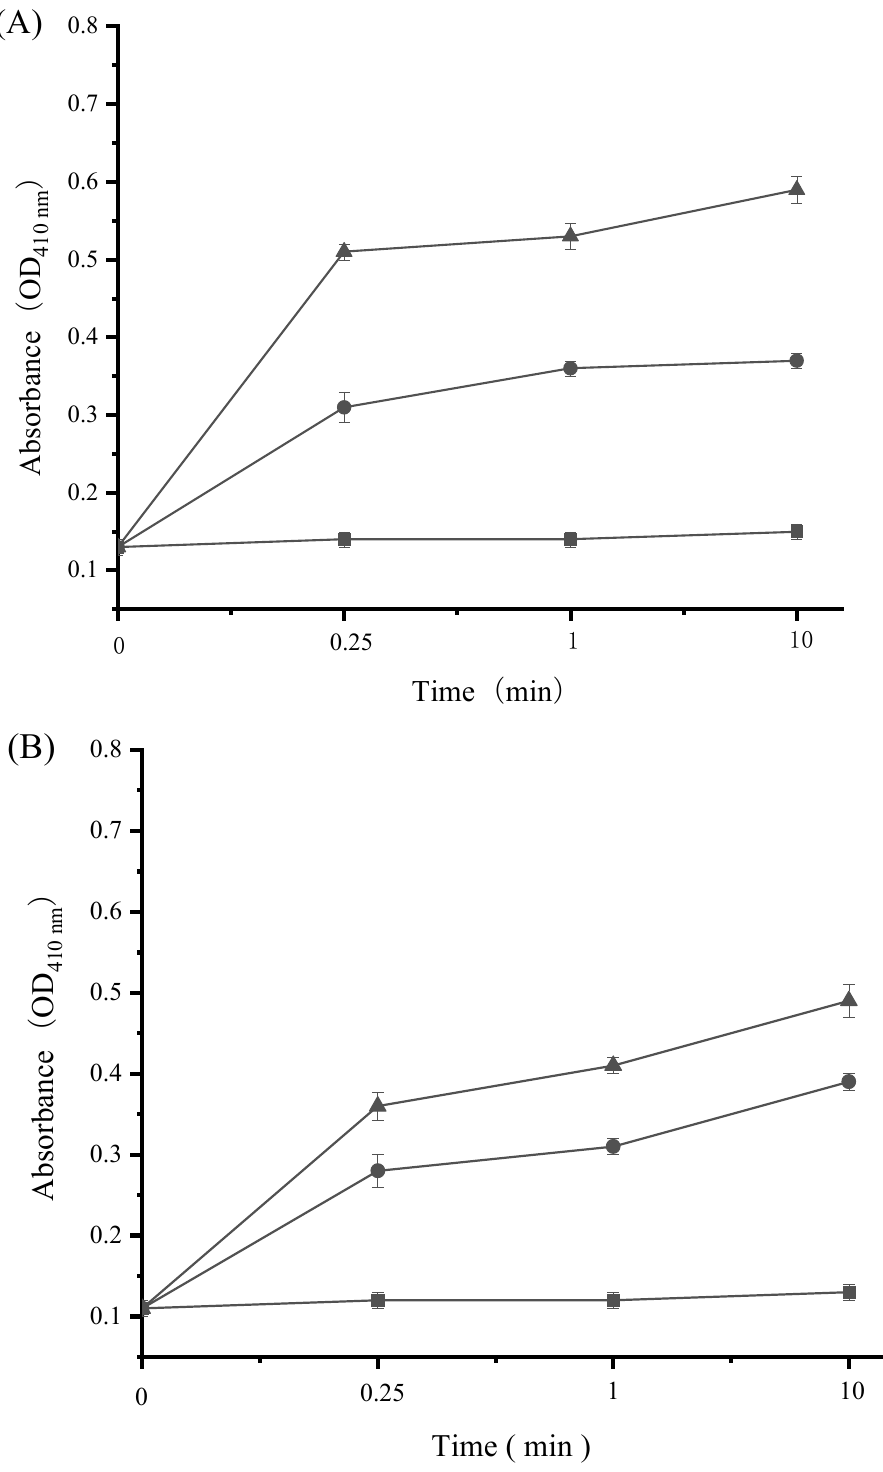
Figure 5. Effect of SAMs on the amount of AKP leakage in E. coli ( A ) and S. aureus ( B ) during incubation at 37 ◦ C for 10 min. The following concentrations of SAMs were used: control ( ■ ), 1/2 × MIC ( ● ), and 1 × MIC ( ▲ ). Values are displayed as the mean ± standard deviation. Error bars show standard deviations, which have been plotted for all data points. Symbols without visible vertical bars suggest that the symbol size is larger than the standard deviation.